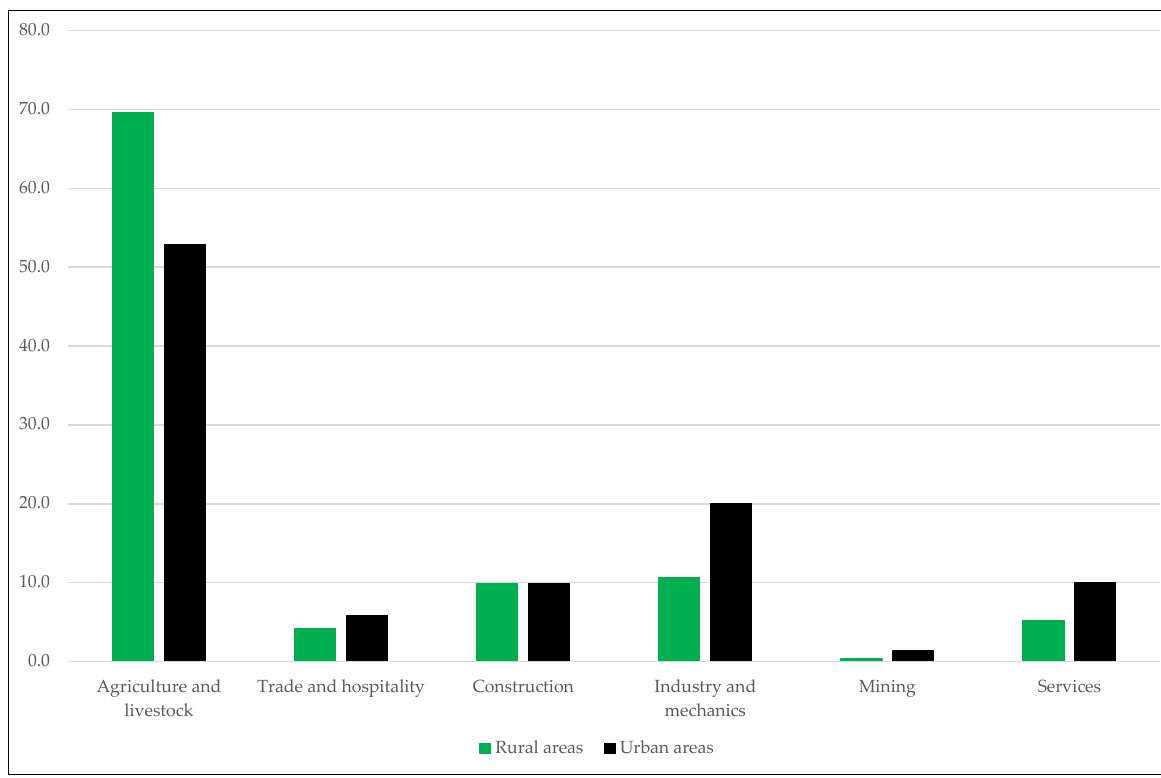
Figure 2. Sectoral distribution of the occupations declared by the recruits included in the sample Extremadura (percentage of cases in each sector over the total records with information on occupation).